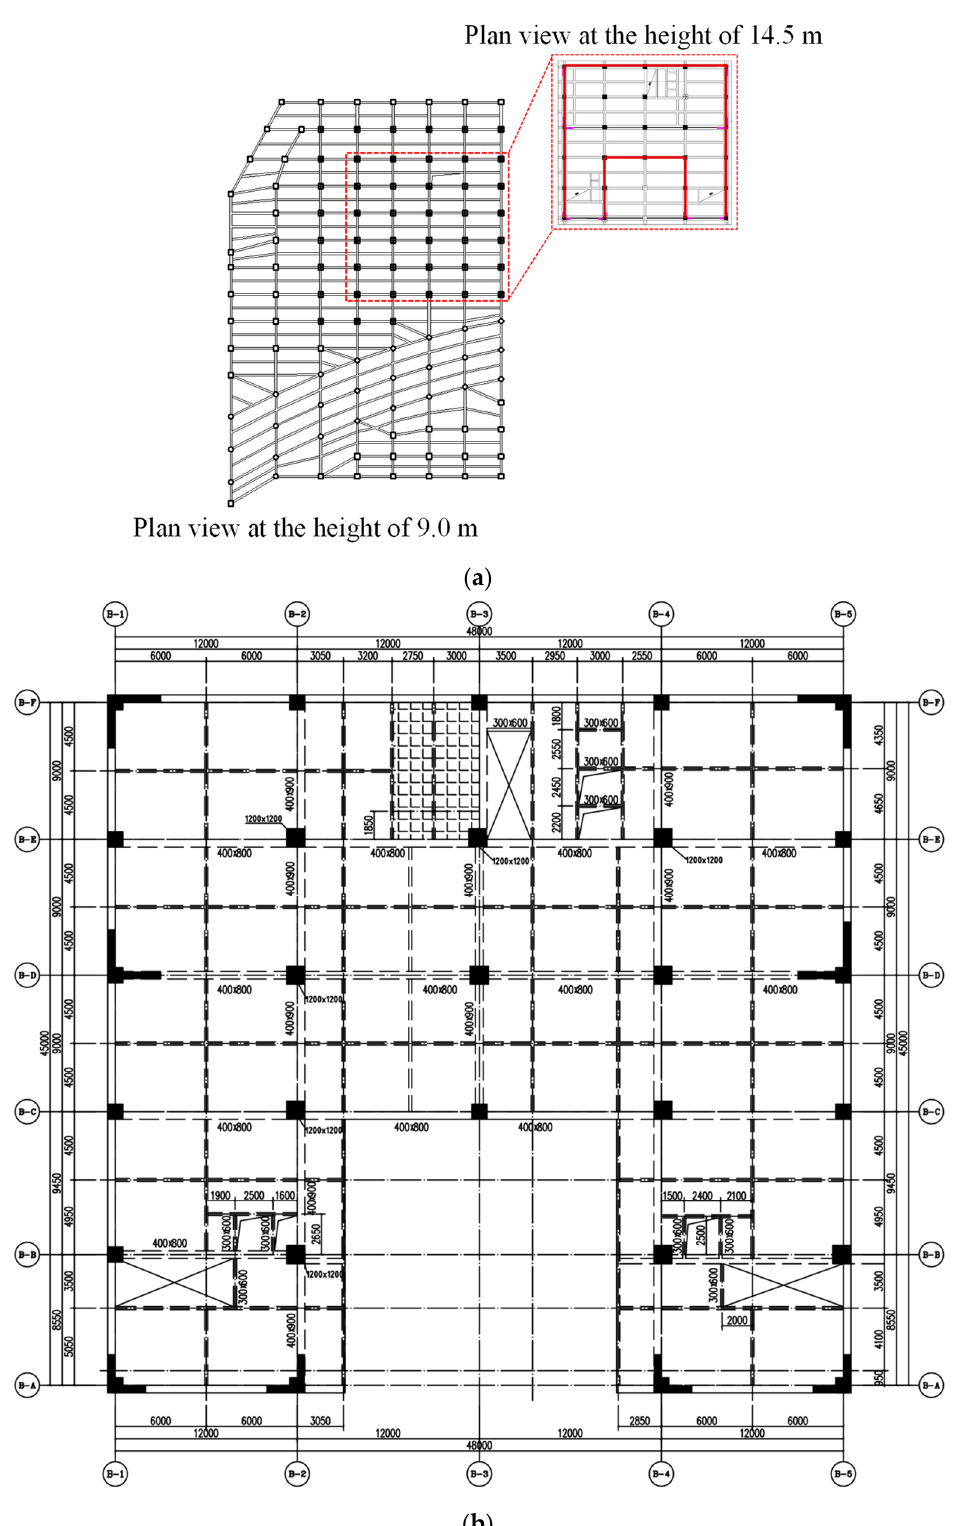
Figure 3. Different plan views of the fourteen-storey Building G1. ( a ) Plan views at the heights of 9.0 m and 14.5 m. ( b ) Plan views of other storeys.